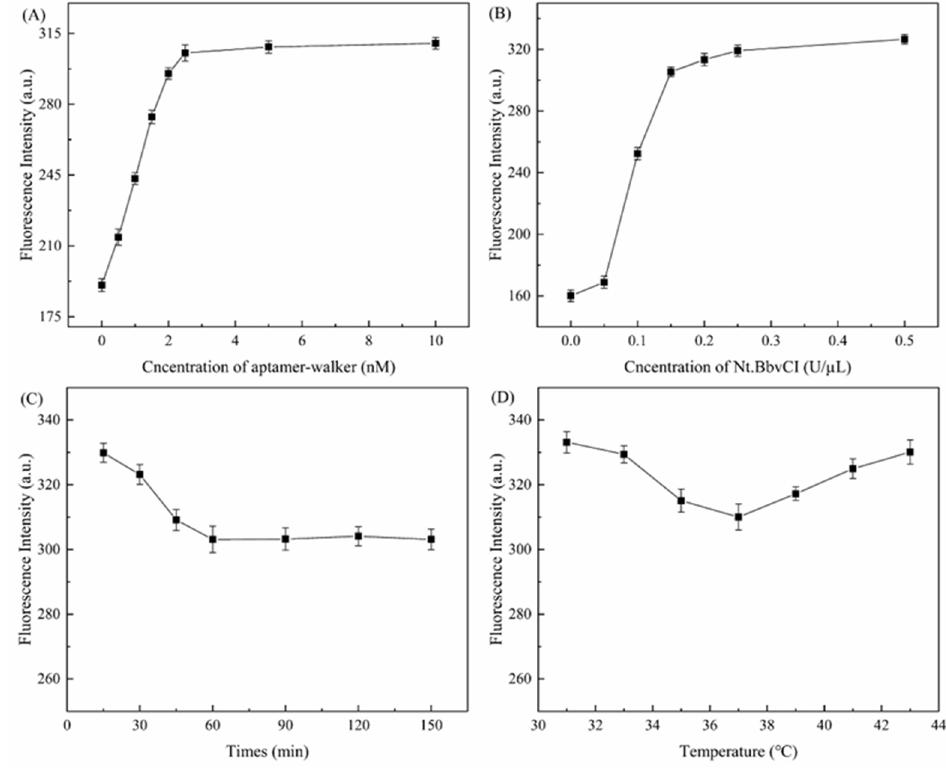
Figure 2. Fluorescence signal curve of the optimized reaction. ( A ) Optimization curve of aptamer- walker concentration. ( B ) Optimization curve of Nt. BbvCI concentration. ( C ) Optimum aptamer- walker and DEHP combination time curve of the reaction system. ( D ) Optimum aptamer-walker and DEHP combination temperature curve of the reaction system.